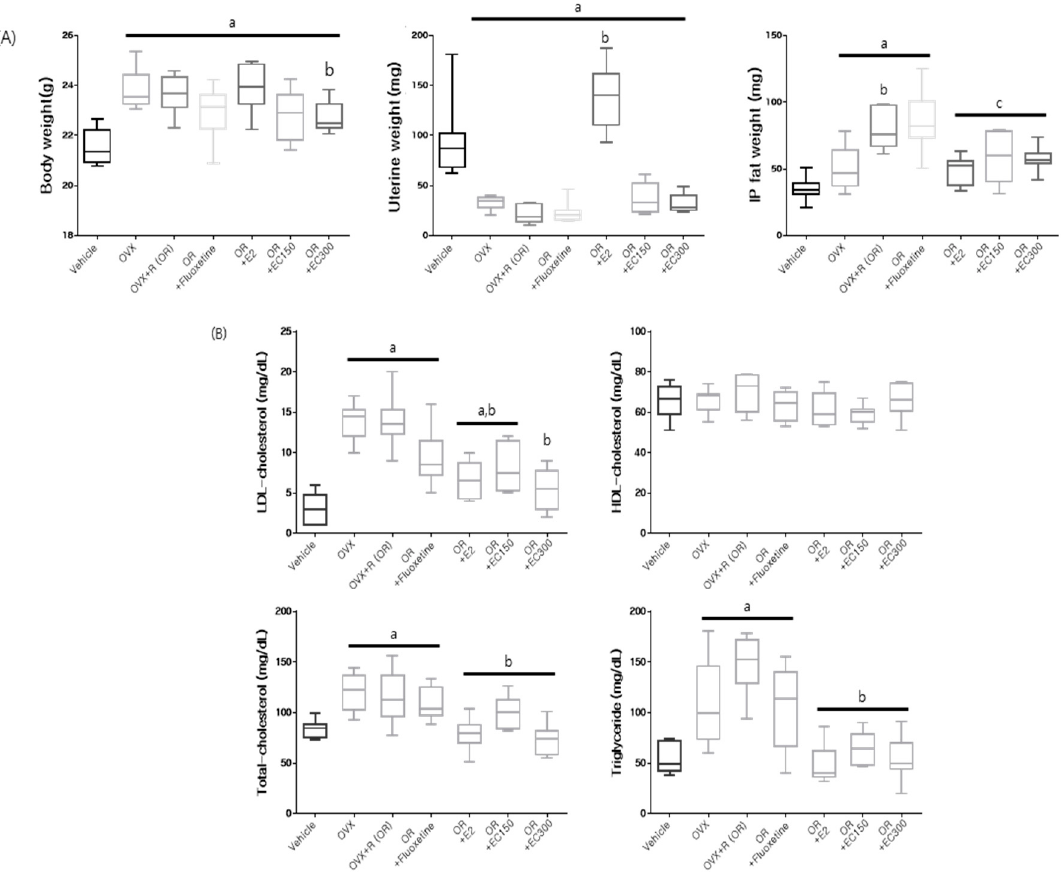
Figure 1. Physiological changes during the experiment. After 8 weeks since ovariectomy, EC extract was administered into mice by oral treatment every day for 8 weeks. ( A ) Body weight, uterine weight, and intraperitoneal (IP) fat weight. ( B ) Serum levels of LDL, HDL, total cholesterol, and triglycerides were measured using a competitive ELISA kit. a p < 0.05 vs. vehicle group. b p < 0.05 vs. OVX. c p < 0.05 vs. OR.